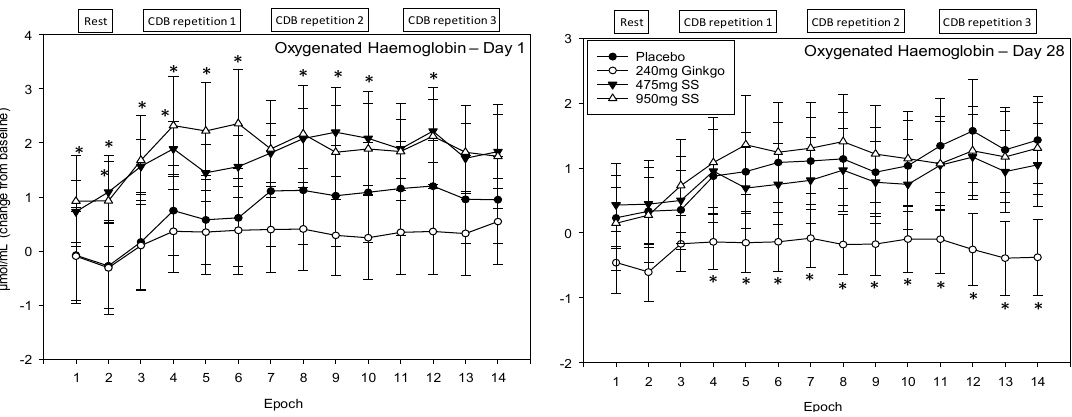
Figure 10. Acute and chronic effects of treatment on oxygenated haemoglobin concentrations. Mean (±SEM) oxygenated haemoglobin concentrations during 5 min of rest (averaged into 2 × 2.5 min epochs) and 30 min (three repetitions) of the cognitive demand battery (CDB). Each 10 min CDB comprises 1 × 2 min epoch of serial 3 and 1 × 2 min epoch of serial 7 subtractions and 2 × 2.5 min epochs of Rapid Visual Information Processing (RVIP). ( left ) Oxygenated haemoglobin changes on Day 1; and ( right ) oxygenated haemoglobin changes following 28 days of supplementation with 475 mg Sideritis scardica (SS), 950 mg SS, active control (240 mg Ginkgo biloba ) or placebo control. Data on both days were recorded during a ~150–240 min post-dose period and converted from the pre-dose baseline on Day 1. * = p <